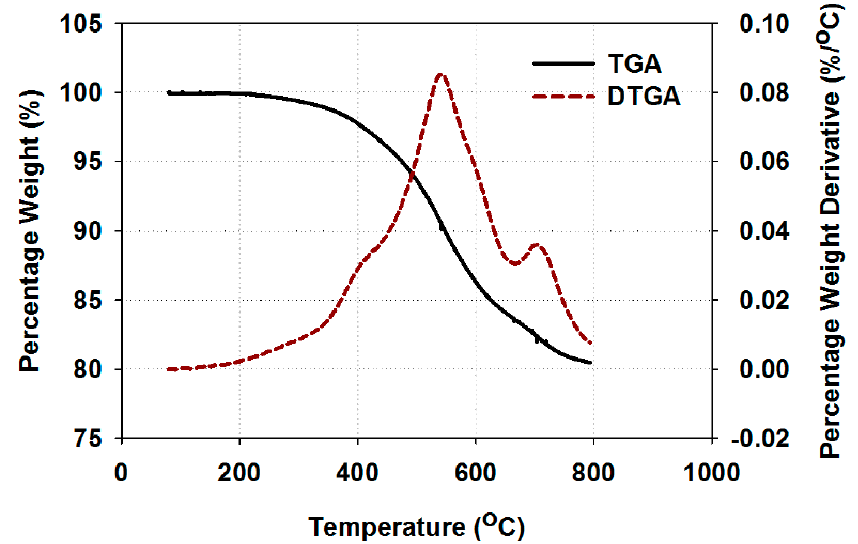
Figure 2. TGA of RTV silicone rubber filled with natural silica to 50 wt.%, performed in Nitrogen atmosphere under a temperature ramping protocol between 80 and 800 °C at a rate of 10 °C/min.